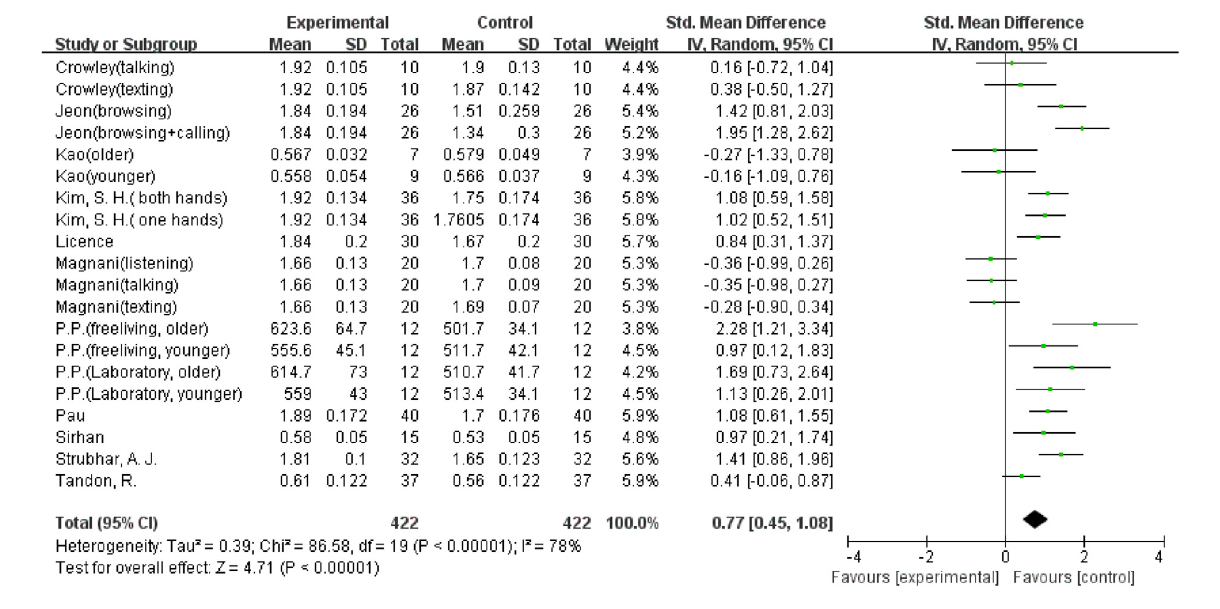
FIGURE 5 The effect of mobile phone use on step